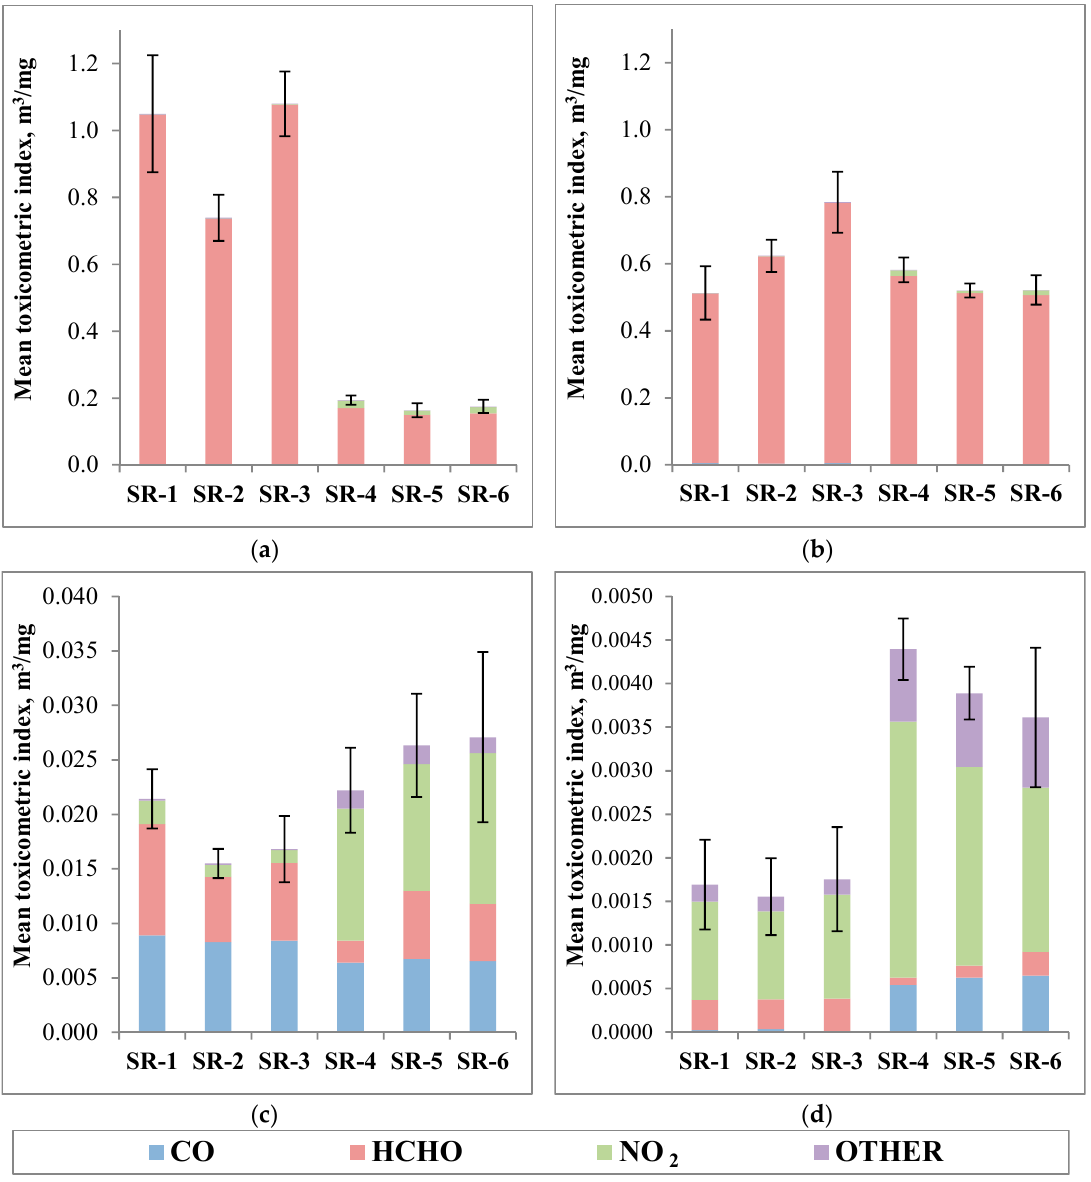
Figure 5. Toxicometric indices evaluated for silicon rubber composites: ( a ) at 500 °C; ( b ) at 600 °C; ( c ) at 700 °C; and, ( d ) at 800 °C. (Note: different scales in each graph).